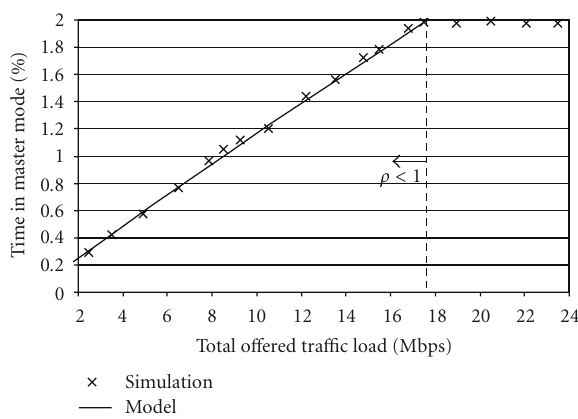
Figure 9: Percentage of time in Master mode (Model versus